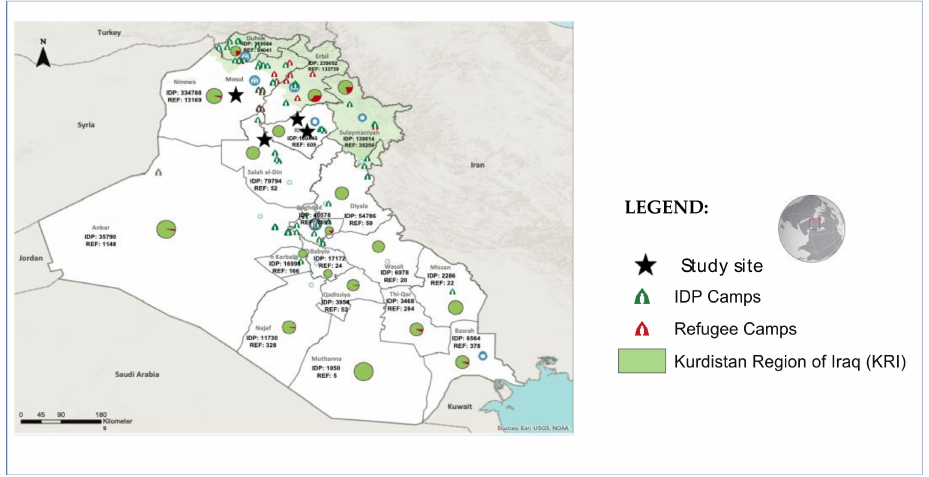
Figure 4. Refugee IDP settlements in Iraq and study sites. Source: Adapted from [11]. IDP—internally displaced persons. January